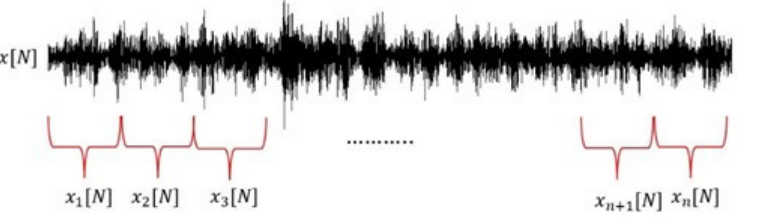
Figure 4. Data augmentation: the original waveform x [ N ] was sectioned into 0.06 s x n [ N ] segments to increase the amount of data for 1D CNN training, validating, and testing.